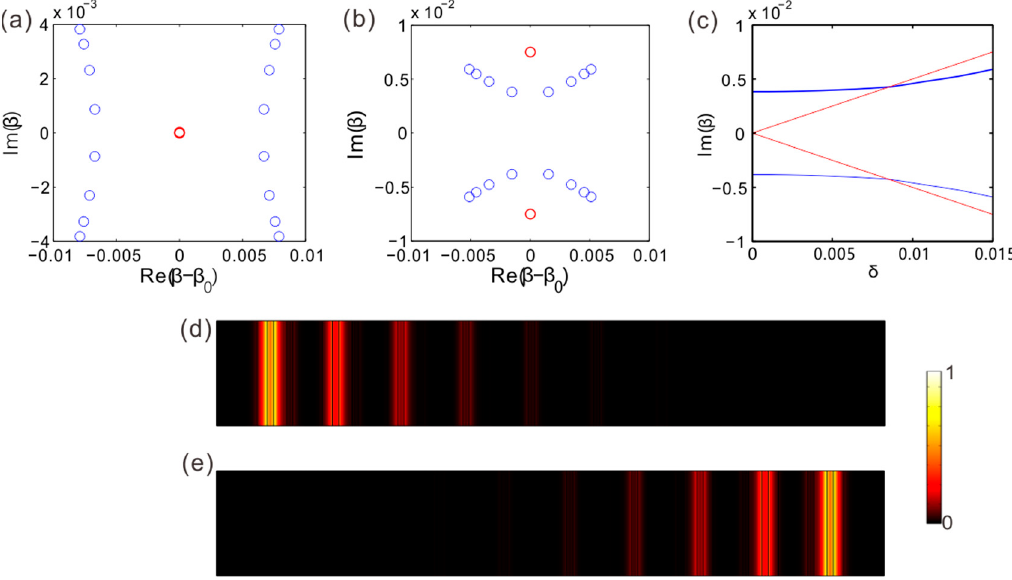
Figure 6. The supermodes for di ff erent detuned propagation constantans i δ . ( a ) The supermode for δ = 0. ( b ) The supermode for δ = 0.015. ( c ) Im( β ) as a function of δ . The blue lines denote the maximum imaginary part of propagation constants for bulk mode. The red lines denote the topological edge mode. ( d ) and ( e ) are the field distributions ( | E | ) of two edge modes for δ = 0.015. The eigenvalues of edge modes are β = ± i δ /2. As δ >> c 1 , c 2 , the eigenvalues of all bulk modes